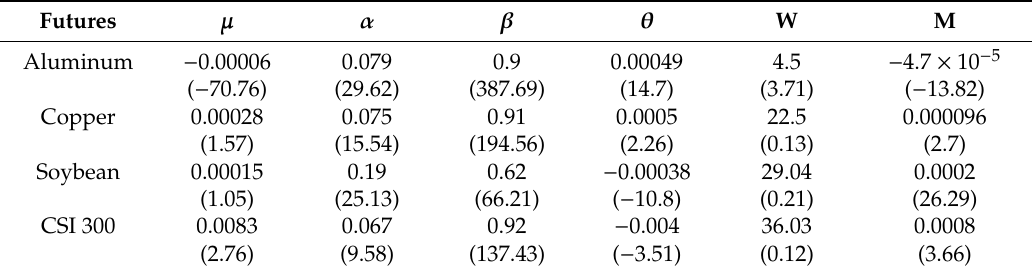
Table 9. Parameter estimates of one side GARCH-MIDAS model with money supply (M2).